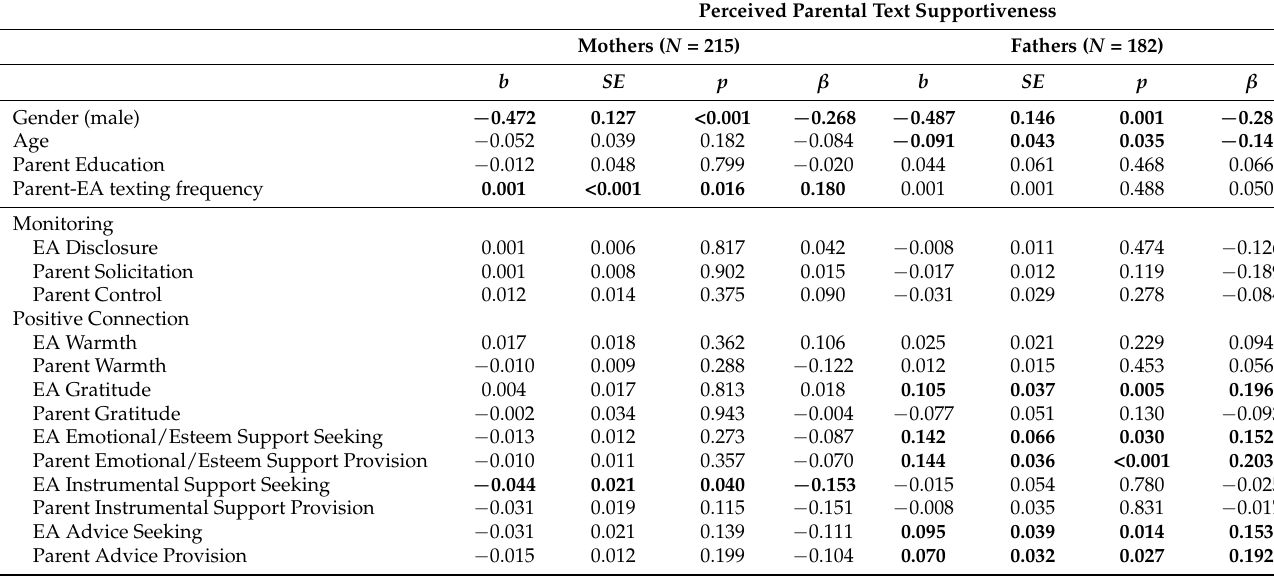
Table 5. Associations between Parent-Emerging Adult Texting Frequency and Content Codes with Emerging Adult Perceived Parental Text